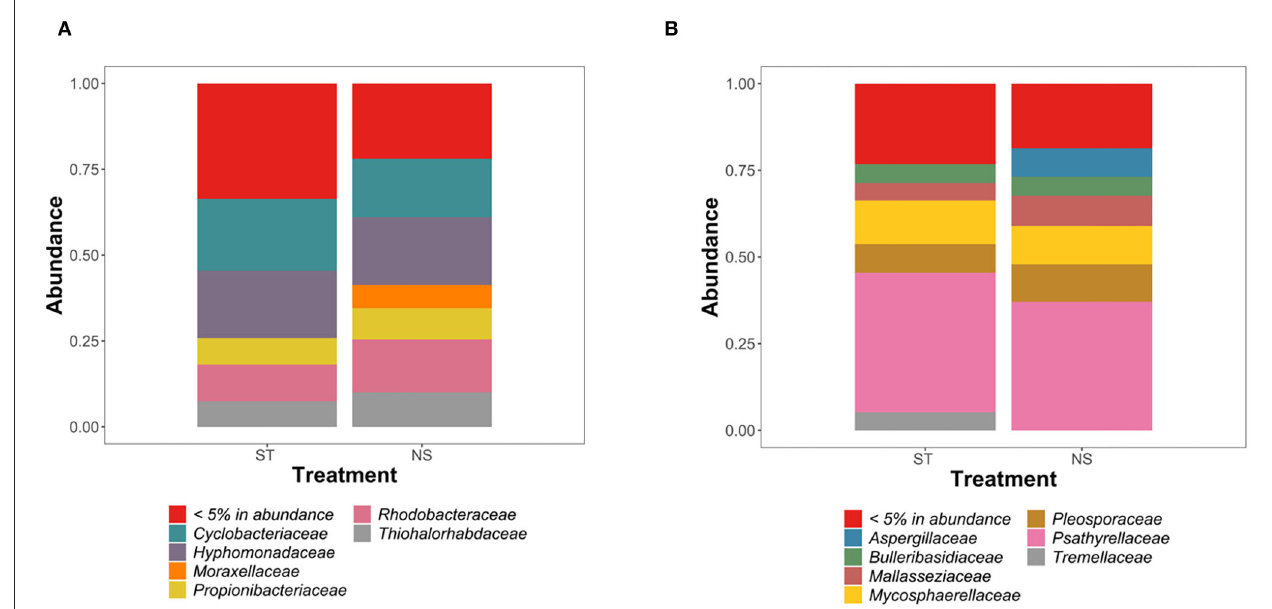
FIGURE 1 | Analysis of the composition of bacterial (A) and fungal (B) communities in “sterilized” (ST) and “non-sterilized” (NS) algal samples.